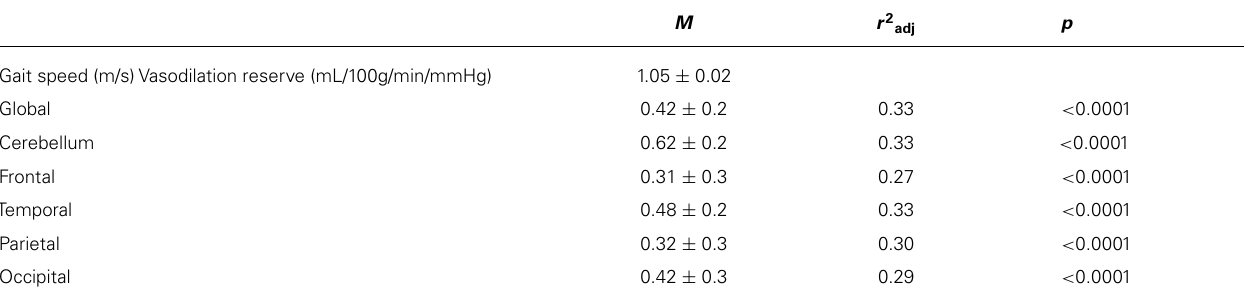
Table 2 |Vasodilation reserve and gait speed relationship in the diabetic